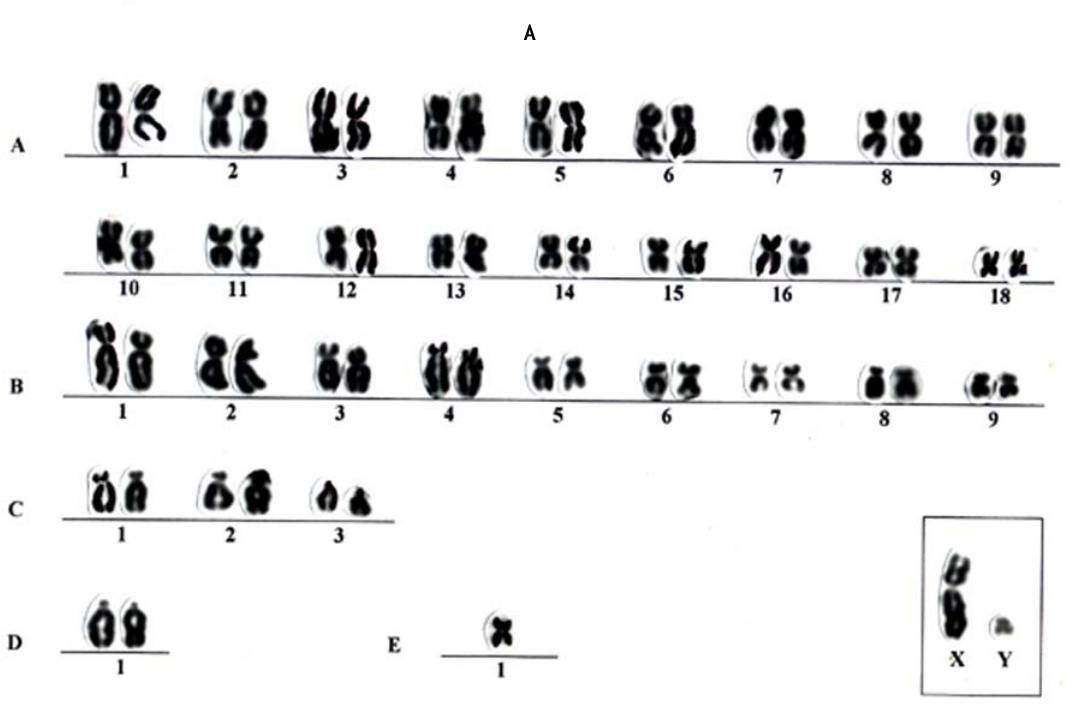
An Acad Bras Cienc (2003) 75